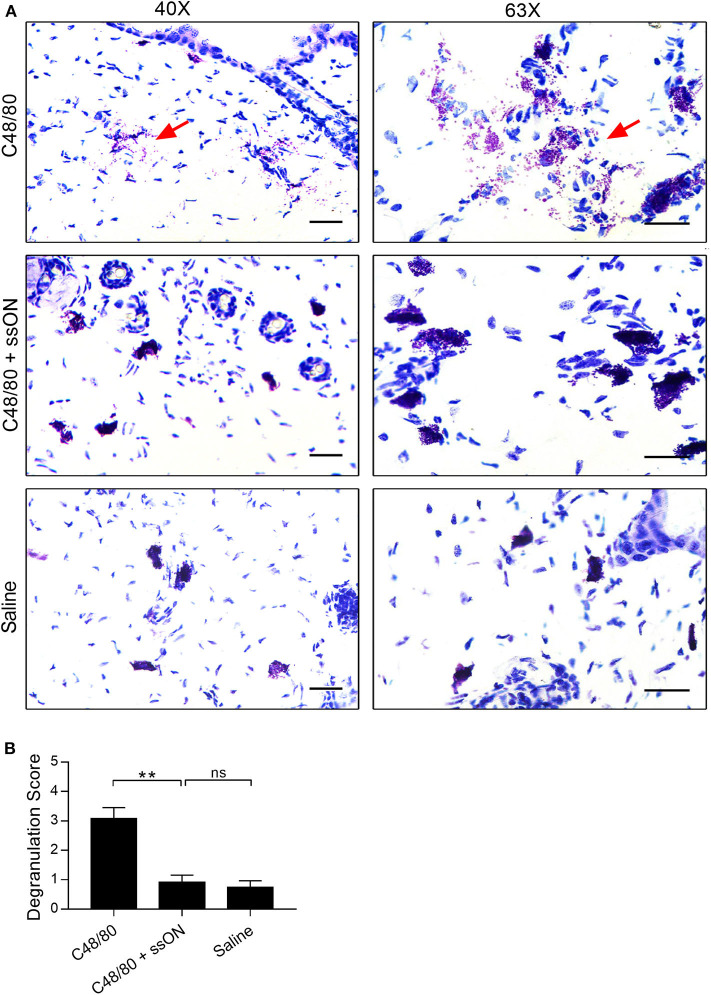
Decreased C48/80-induced mast cell degranulation in mouse skin with ssON treatment. Skin biopsies were taken from mice 1 h post-treatment at the injection site, and then stained with Toluidine Blue. Each sample was graded for mast cell degranulation and given a score using a scale from 0 to 4: a score of 0 was given for intact mast cells; 1, for mostly intact; 2, for mild degranulation; 3, for moderate degranulation; and 4, for heavy degranulation. (A) Representative histological sections and (B) the average scores are shown for each treatment group. An average score of 3.0 was determined for C48/80 (10 μg) treatment, a score of 0.9 was determined for the combination treatment of C48/80 and ssON (10 and 25 μg, respectively), and a score of 0.8 was determined for saline treatment. Left panels, magnification at 40X; right panels, magnification 63X. All scale bars represent 10 μm. Red arrows point to degranulation events. N=6 for each group. Statistical significance was assessed by non-parametric Mann-Whitney test. P-value: **P < 0.01, ns, non-significant. Data is shown as mean ± SEM.